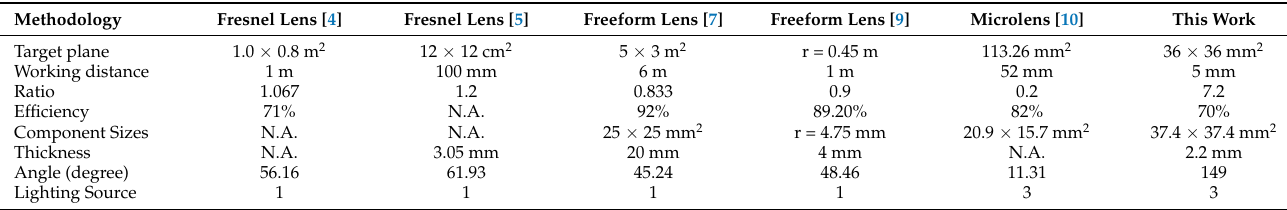
Table 2. The comparison chart for different